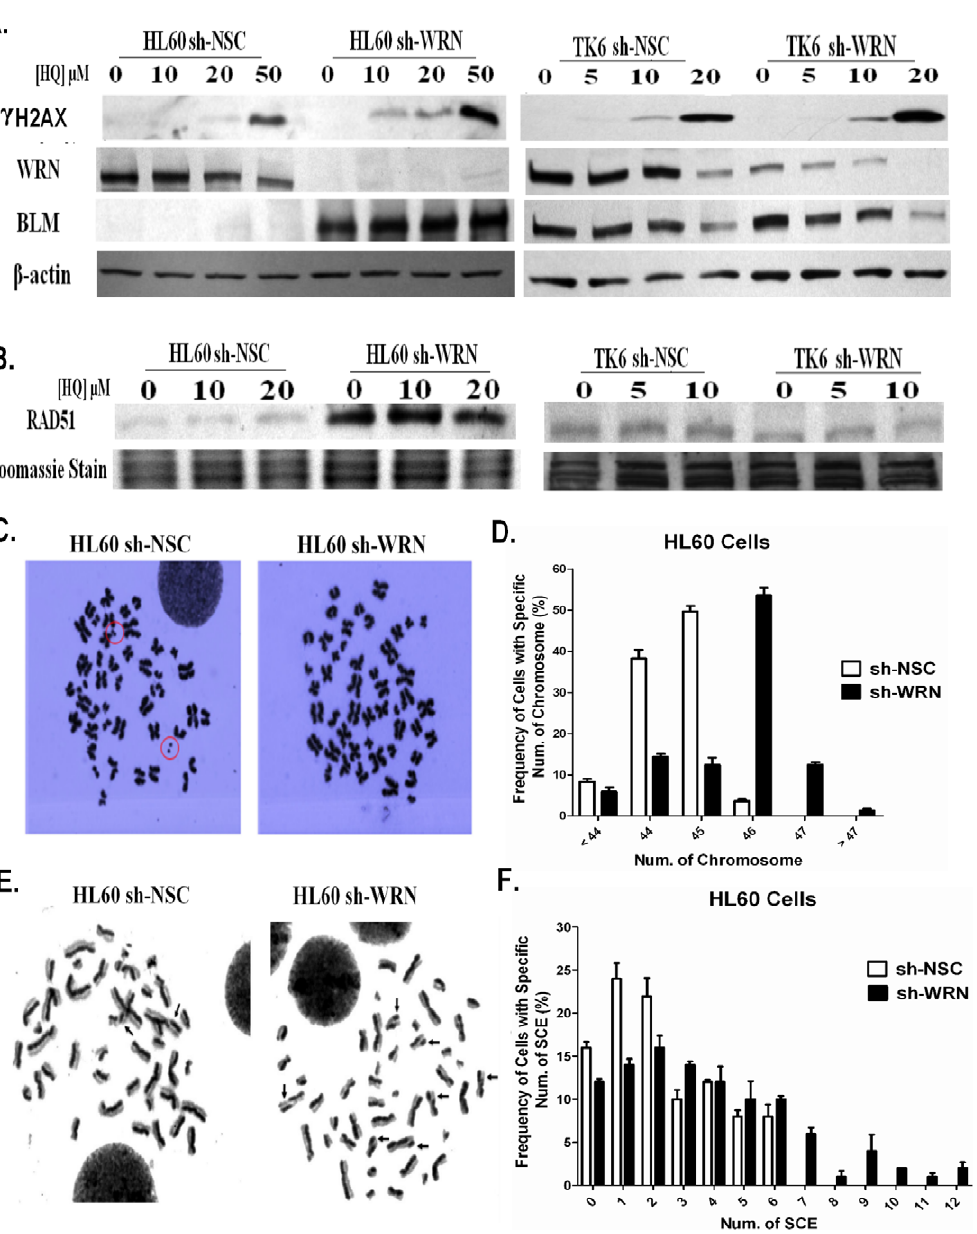
Figure 4. WRN depletion in HL60 cells leads to hyper-activated HR, DNA damage disrepair and chromosomal aberrations. (A & B) Representative images of immunoblot analysis performed using antibodies against c H2AX, WRN, BLM in whole cell lysate and RAD51 on nuclear extracts. Immunoblot analysis showed that accumulation of c H2AX in cells exposed to HQ for 24h in a dose-dependent manner. BLM and RAD51 dramatically increased in HL60 sh-WRN cells compared to HL60 sh-NSC cells regardless of HQ treatment. WRN depletion in TK6 cells slightly reduced RAD51 protein levels. (C) Double minutes (marked with red circle), the characteristic chromosomal aberration in HL60 cells, were absent in HL60 sh- WRN cells regardless of HQ treatment. (D) Aneuploidy in WRN deficient HL60 cells resolved to 46 chromosomes versus 44 or 45 typical of control HL60 cells. (E) Representative images of SCE in HL60 sh-NSC and HL60 sh-WRN cells are shown (marked with arrow). (F) Cells with a higher frequency of SCE are observed in HL60 sh-WRN when compared to the HL60 sh-NSC